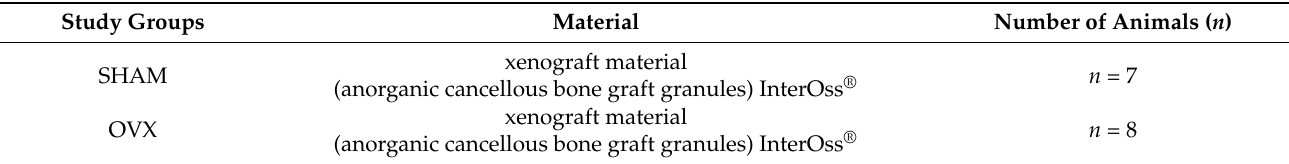
Table 1. Study groups, material and number of animals ( n